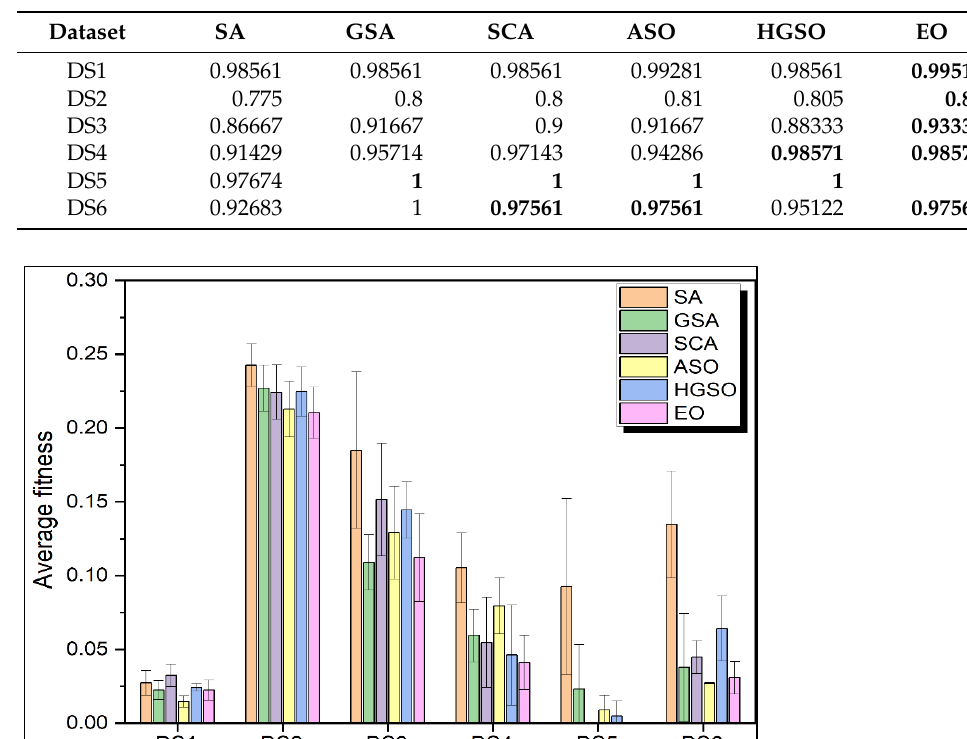
Figure 2. Average fitness and standard deviation of all algorithms on all selected datasets.